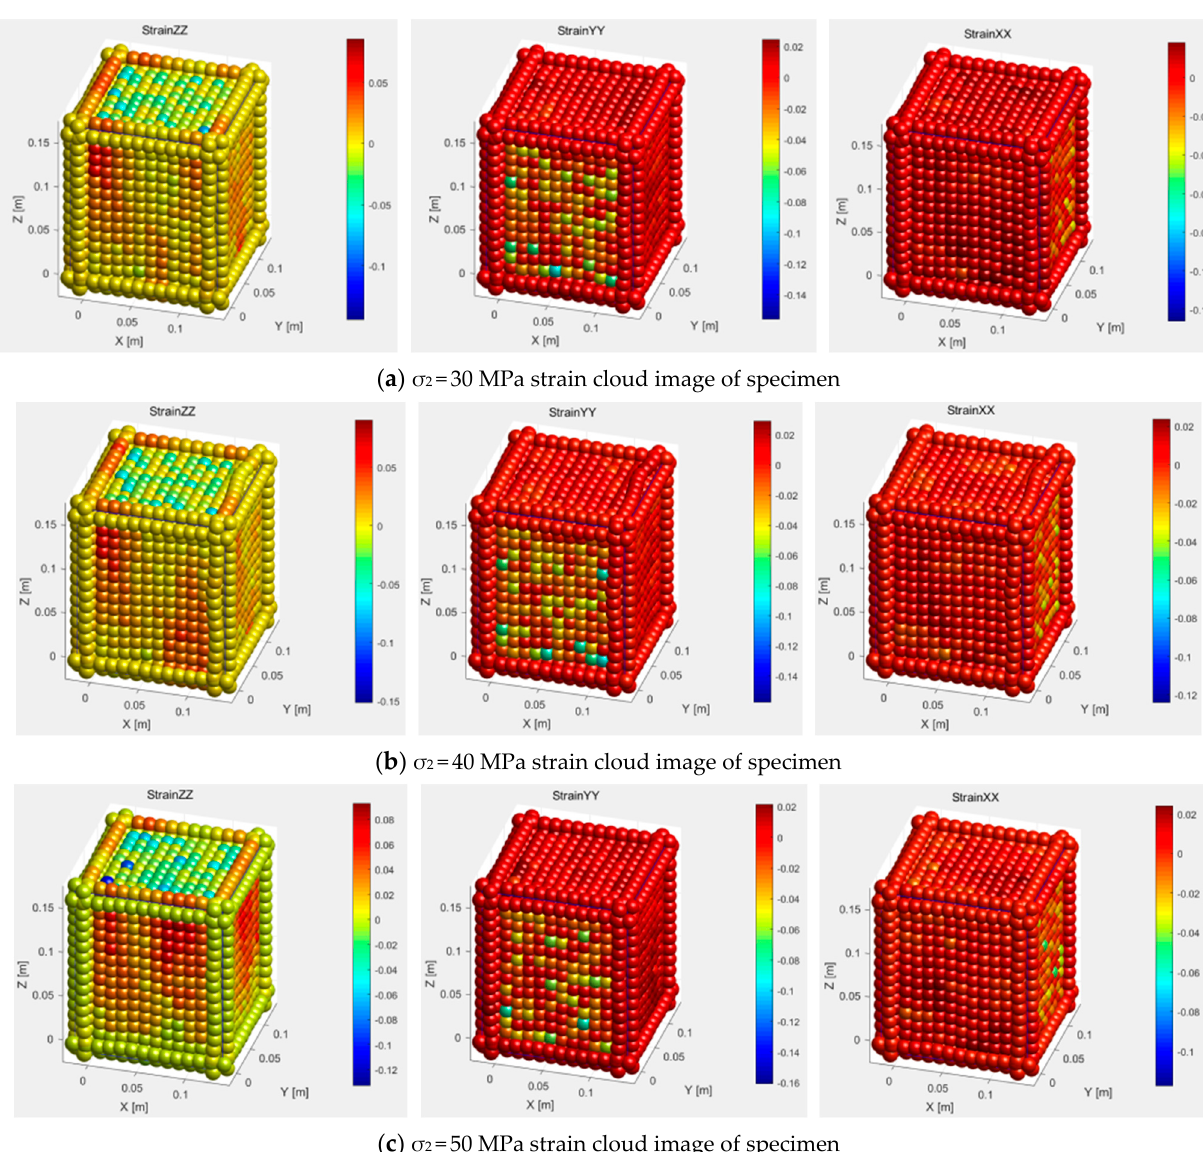
Figure 6. Anisotropic strain cloud diagram of sandstone specimens under different medium princi- pal